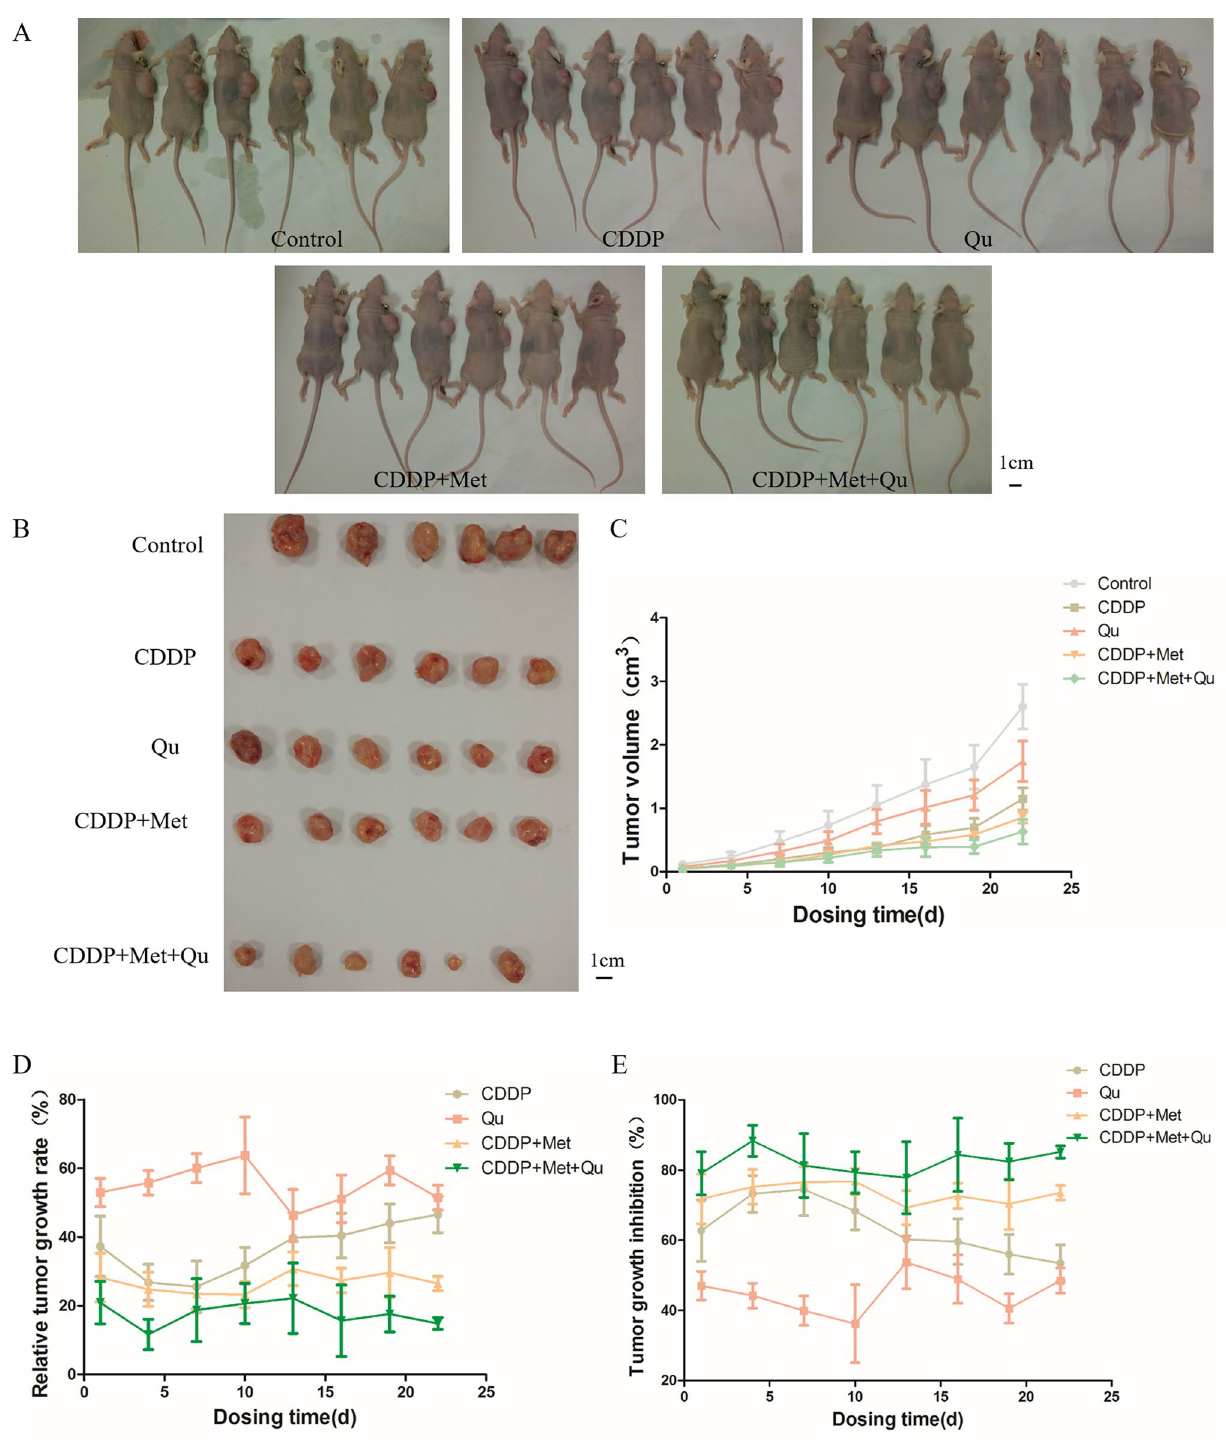
Figure 4. The effect of different combined regimens of cisplatin, metformin, and quercetin on the growth of xenograft tumor. ( A , B ) Growth of xenograft tumors in nude mouse after 8 times of dosing, ( C ) Tumor volume at different dosing time, ( D ) relative tumor growth rate at different dosing times, ( E) tumor growth inhibition at different dosing